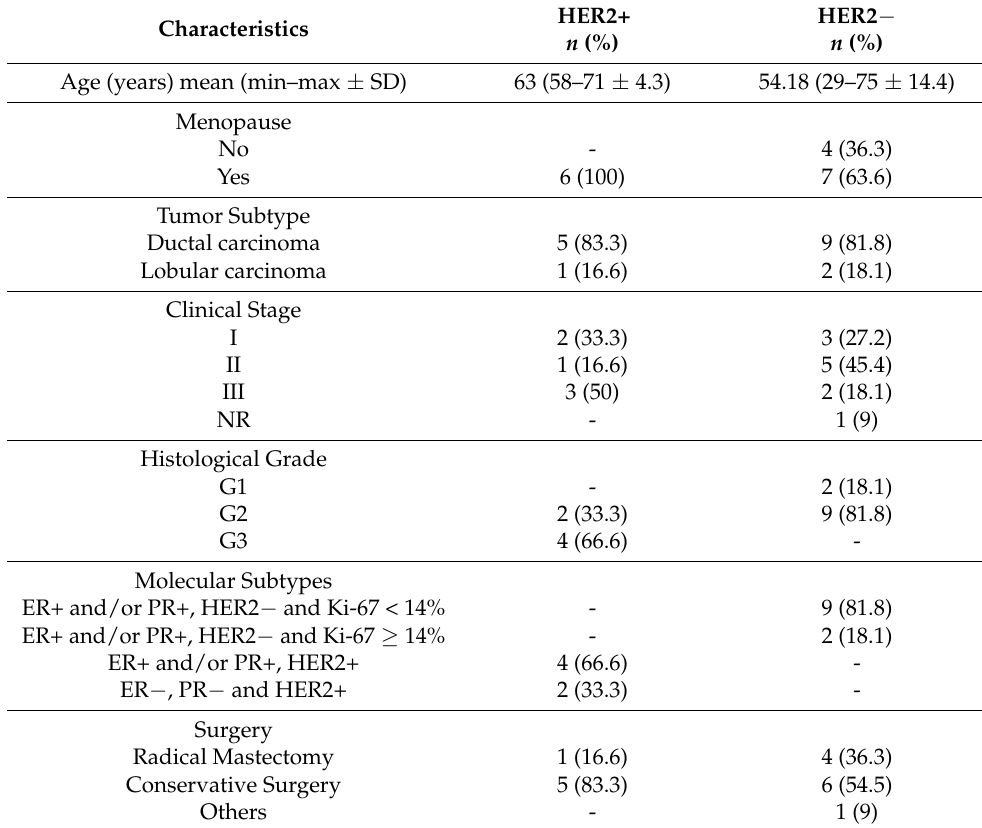
Table 1. Clinical and histopathological characteristics of women with breast cancer ( n = 17).